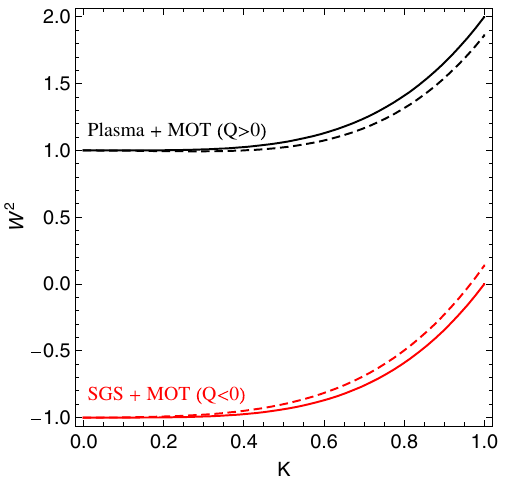
Figure 1. Dimensionless dispersion relations (32), covering the three scenarios of SGSs, plasmas, and MOTs. 0 while dashed lines represent L Solid lines correspond to L = =